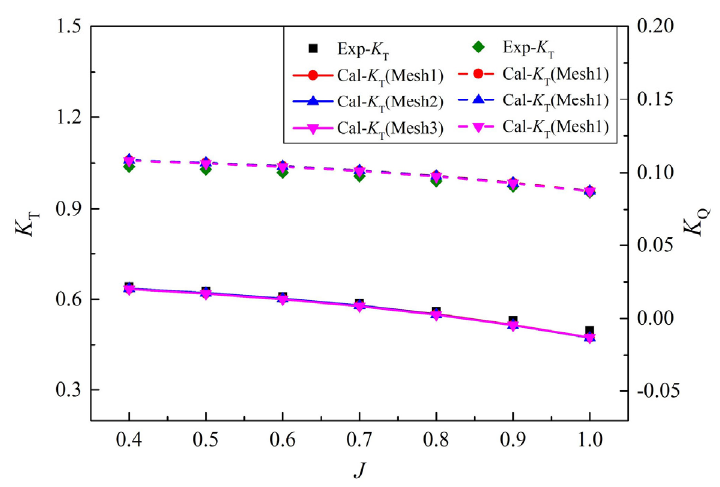
Figure 3. Comparison of the experimental and calculated hydrodynamic performance for the pump